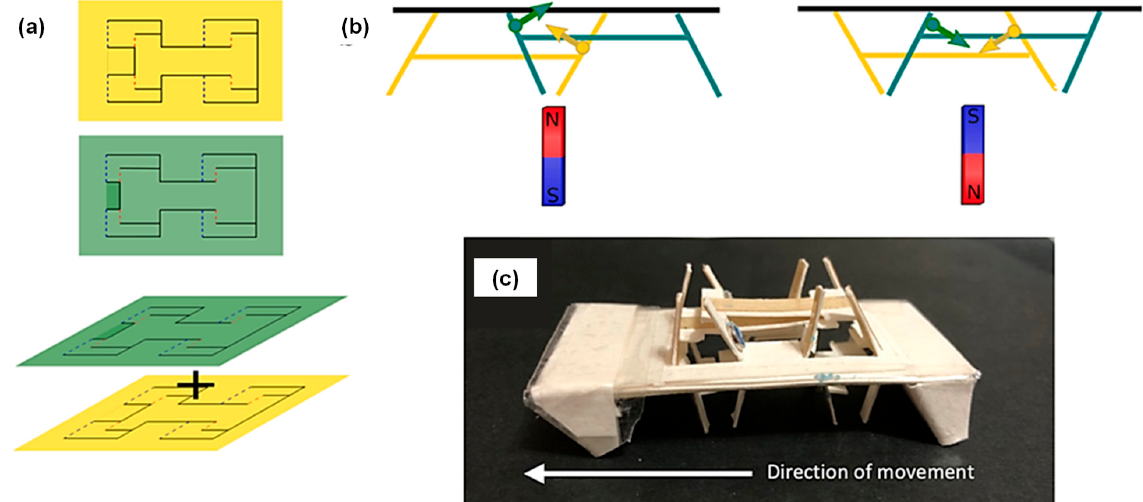
Figure 4. AMDLEM with an assembly of four LEM sheets. ( a ) Design of the two LEM sheets that can be assembled to form one side of the AMDLEM. Dotted lines represent mountain and valley folds; continuous black lines represent cuts. ( b ) Side view of the assembled two SLEM sheets from ( a ) when under the influence of the magnetic field generated by the interactions between the APM and IPM. The dots and arrows indicate the position and dipole orientation of the attached IPM. There are two alternating configurations, where each configuration shows the leg pairs mirroring each other. ( c ) A prototype with two sides of dual SLEM sheets and directional